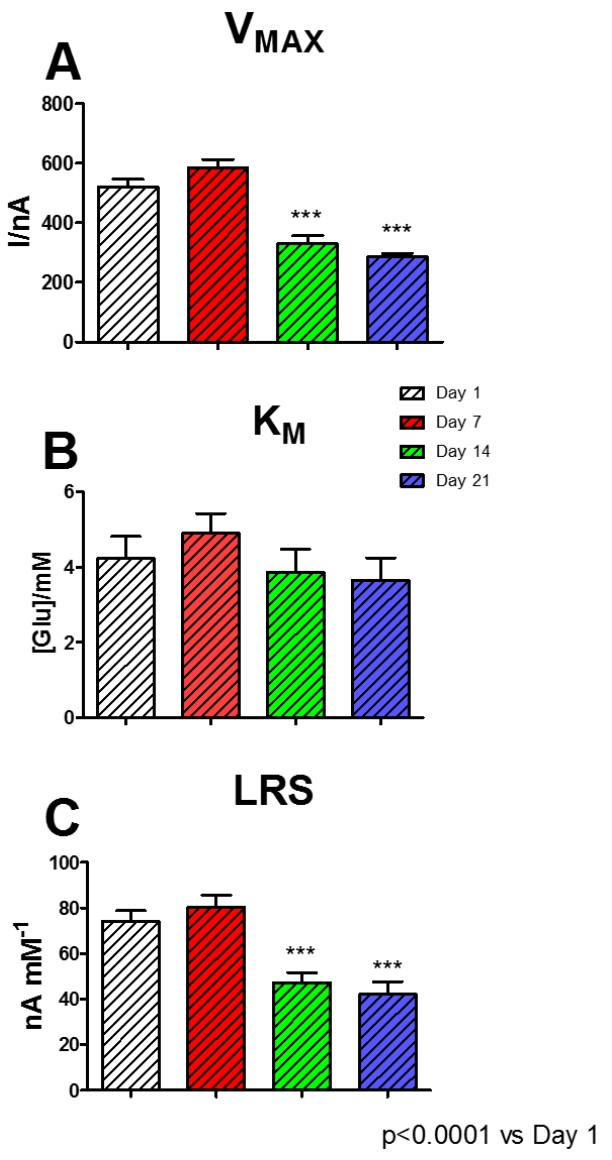
Figure 6. Glucose biosensor stability over time. Bar chart displaying the changes of V MAX (Panel A ), K M (Panel B ), and LRS (Panel C ) on the highest performing biosensor design B4: Pt c /[GEL(5%) + PEI(1%) + GLY(1%) + GOx] 5 /PPD, in a period of 21 days. White bar: Day 1; red bar: Day 7; green bar: Day 14; blue bar: Day 21. Values are expressed as mean ± SEM. * p < 0.0001 vs. Day 1.